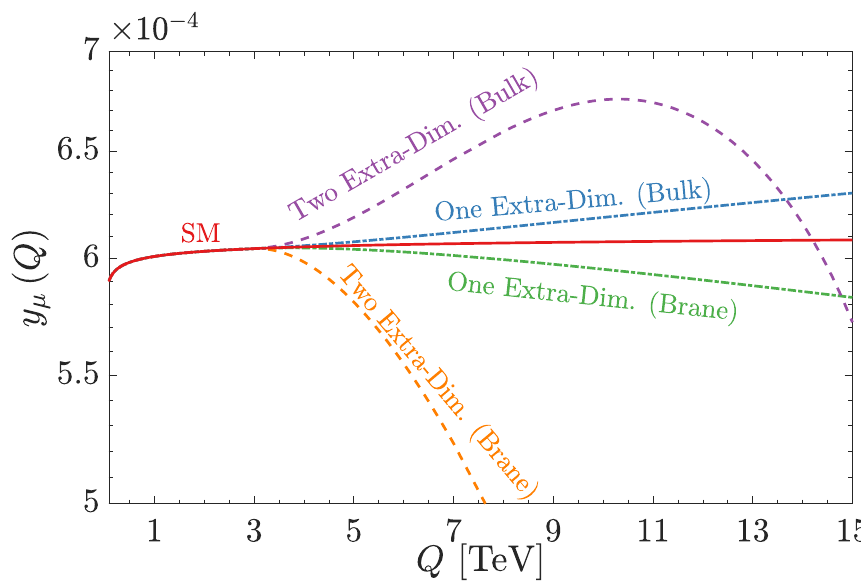
Figure 1 . LO RGE running of the muon Yukawa y µ coupling as a function of the energy scale Q , in the SM (red solid). In the extra-dimensional scenarios (with inverse radius 1 /R = 3 TeV), we consider 1) Bulk: all fields propagating in the bulk, and 2) Brane: all matter fields localized to the